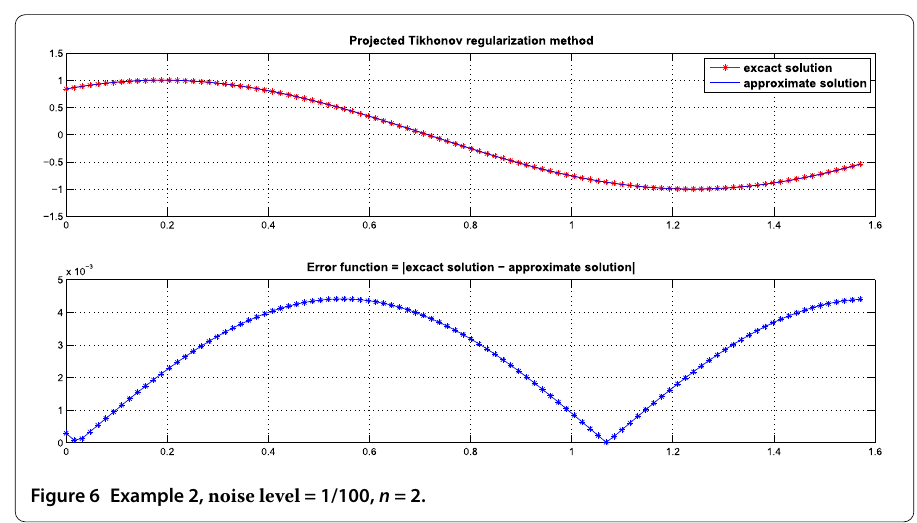
Figure 6 Example 2, noise level = 1/100, n = 2.